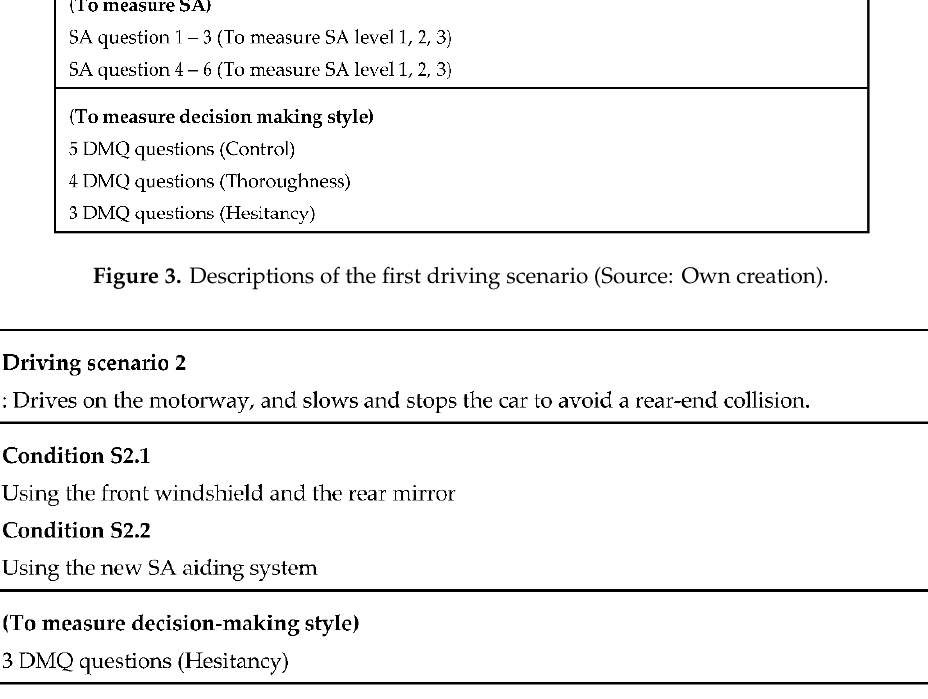
Figure 4. Descriptions of the second driving scenario (Source: Own creation).